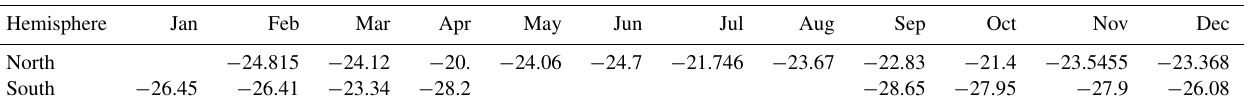
Figure 7. The north–south trend of sampled δ 13 C POC values is visualized by a cross section over the Atlantic Ocean. Biomes (Fay and McKinley, 2014) define the latitudinal bands of the interpolated data set. Panel (a) presents a Gaussian KDE for each biome approximating the density of the contained δ 13 C POC data. Different colors mark the individual biomes, and a black line shows the general global δ 13 C POC distribution. The number in parentheses in each KDE label counts the number of δ 13 C POC measurements used for the respective graph. Panel (b) shows in a box plot the steep decline in δ 13 C POC values from the tropical biomes towards the higher latitudes. The x axis provides the mean latitudes of the biomes introduced in (a) . The y axis measures the δ 13 C POC value. Panel (c) shows the biome locations. Each biome is drawn in the color of its corresponding density estimate in (a) above. The biome numbers increase from the north to the south. Table 5. Monthly median change in δ 13 C POC . Due to their having the best data coverage, the analyses were carried out within the 1990s and in the uppermost